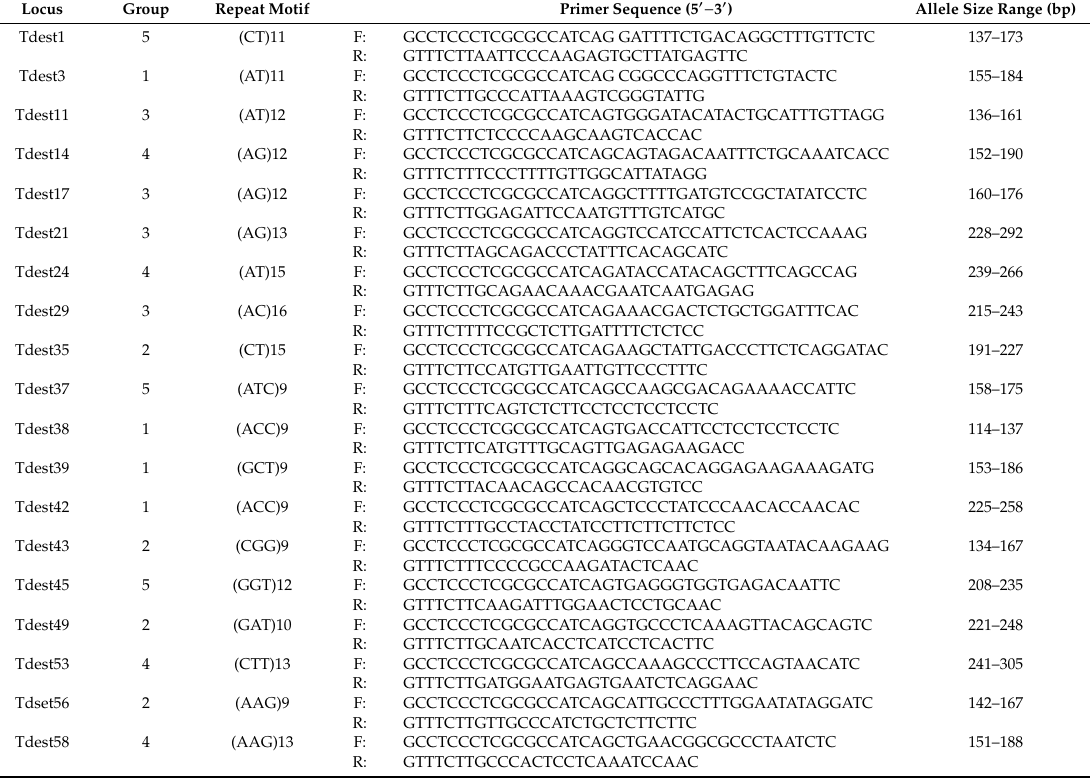
Figure A3. Relationships between the number of clusters (K) and the rate of the change in lnP(X | K) (Delta K ), based on STRUCTURE analysis. Table A1. Characteristics of 19 EST-SSR loci for use in the genus Thujopsis